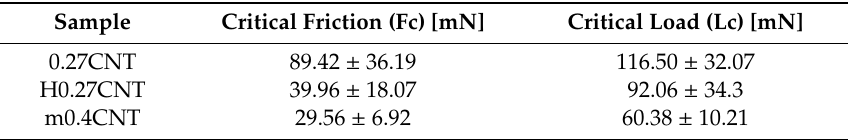
Figure 6. Friction (F) dependence on load (L) with the indicated critical load (Lc) for the single measurement of ( A ) the carbon nanotube coating on the surface of Ti13Nb13Zr (0.27CNT), ( B ) the carbon nanotube coating on the surface of the hydroxyapatite (H0.27CNT), ( C ) the mixed coating consisting of carbon nanotubes, nanohydroxyapatite, nanosilver and nanocopper (m0.4CNT). Table 5. Parameters of coatings delamination.